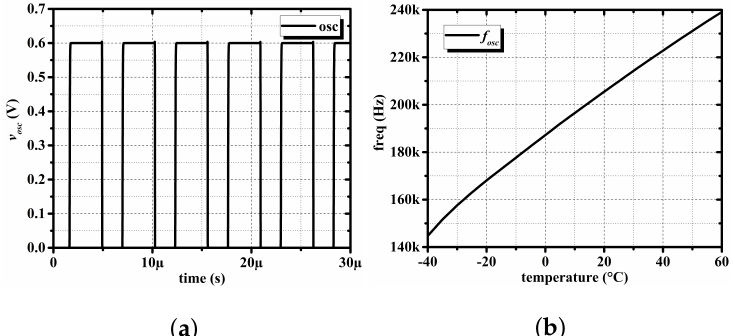
Figure 15. Oscillator post-layout simulation. ( a ) Oscillation frequency at 25 °C. ( b ) Oscillation frequency temperature sweep.